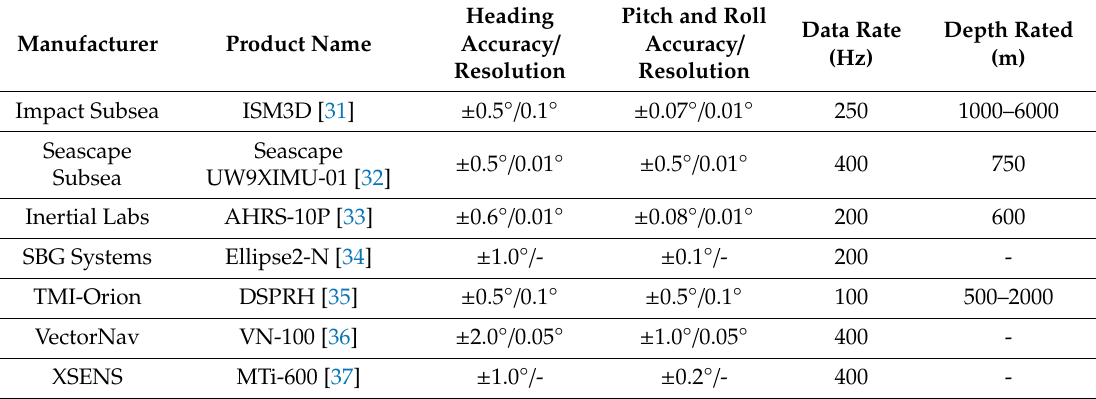
Table 1. Commercial Inertial Measurement Unit (IMU)-Attitude and Heading Reference System